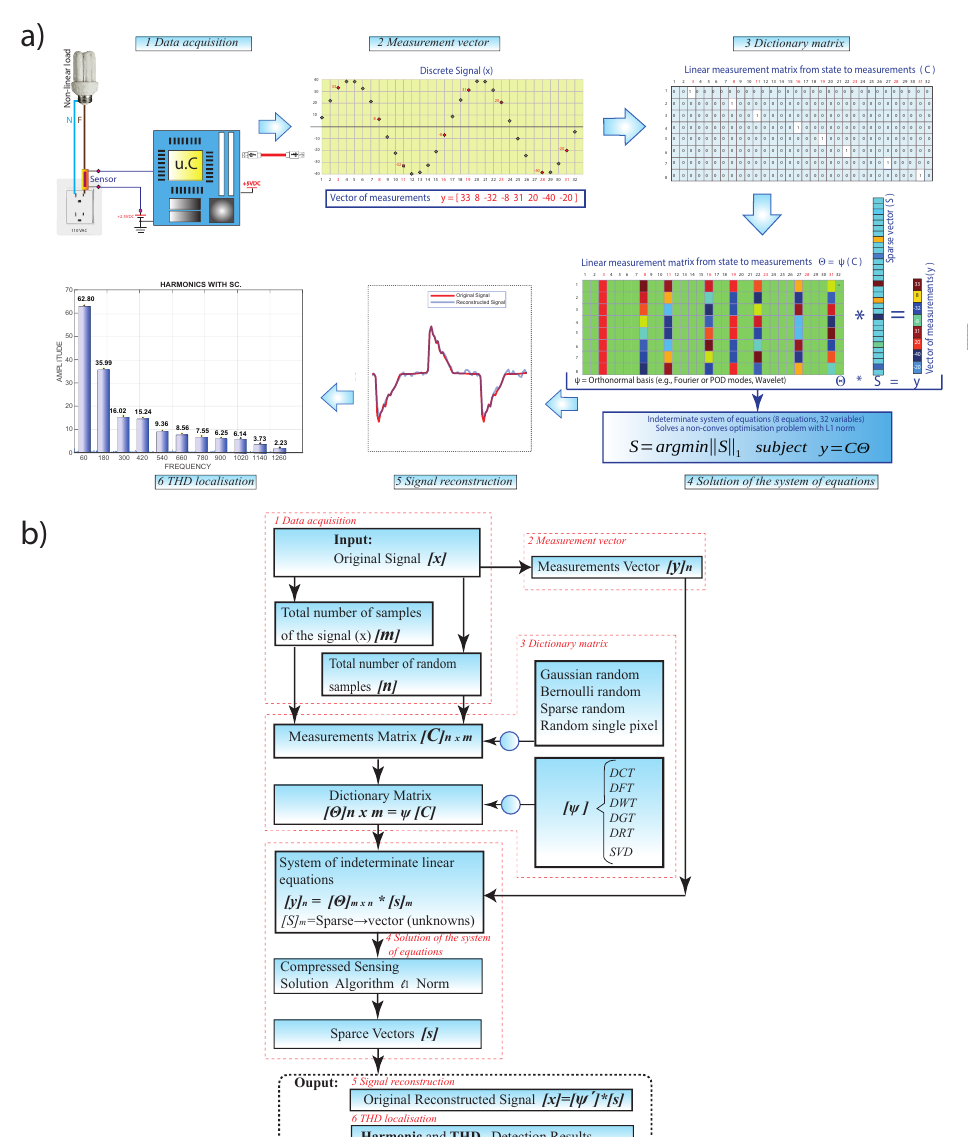
Figure 3. ( a ) General block diagram and ( b ) flow diagram of the proposed